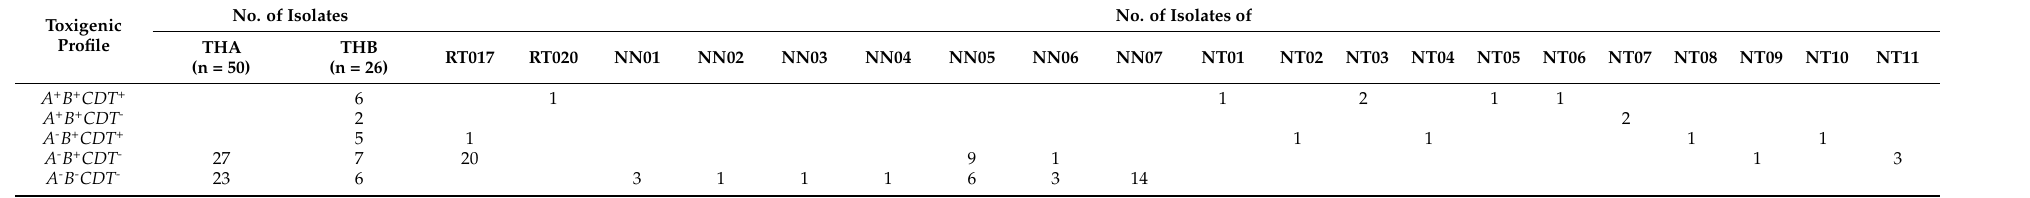
Figure 2. Ribotypes of C. difficile isolates using PCR ribotyping method. ( A ) The distribution of ribotypes among C. difficile isolates in the THA group (n = 50). ( B ) The distribution of ribotypes among C. difficile isolates in the THB group (n = 26). PCR ribotyping was performed on 16S and 23S rRNA genes. Ribotypes were assigned based on the band patterns of gel electrophoresis. RT017 and RT020 represent the standard C. difficile ribotypes. NT and NN represent new ribotype patterns of C. difficile toxigenic and non-toxigenic isolates, respectively. Table 1. Summary of toxin gene profiles and ribotyping profiles of 76 C. difficile isolates in